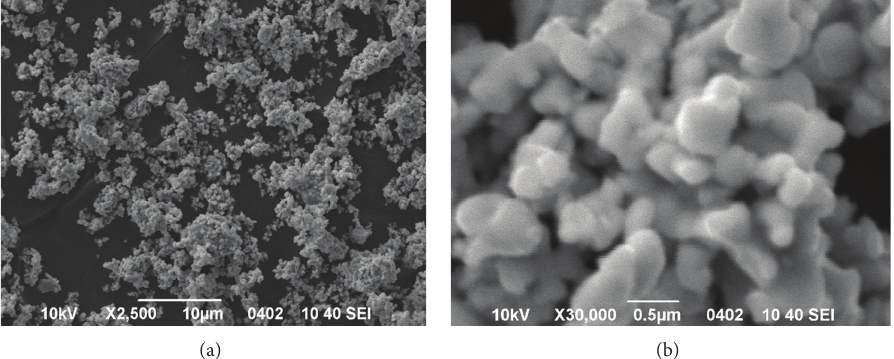
F 3: SEM scans of the sample surface �ith ma�ni�cations: (a) 2,���, (b)